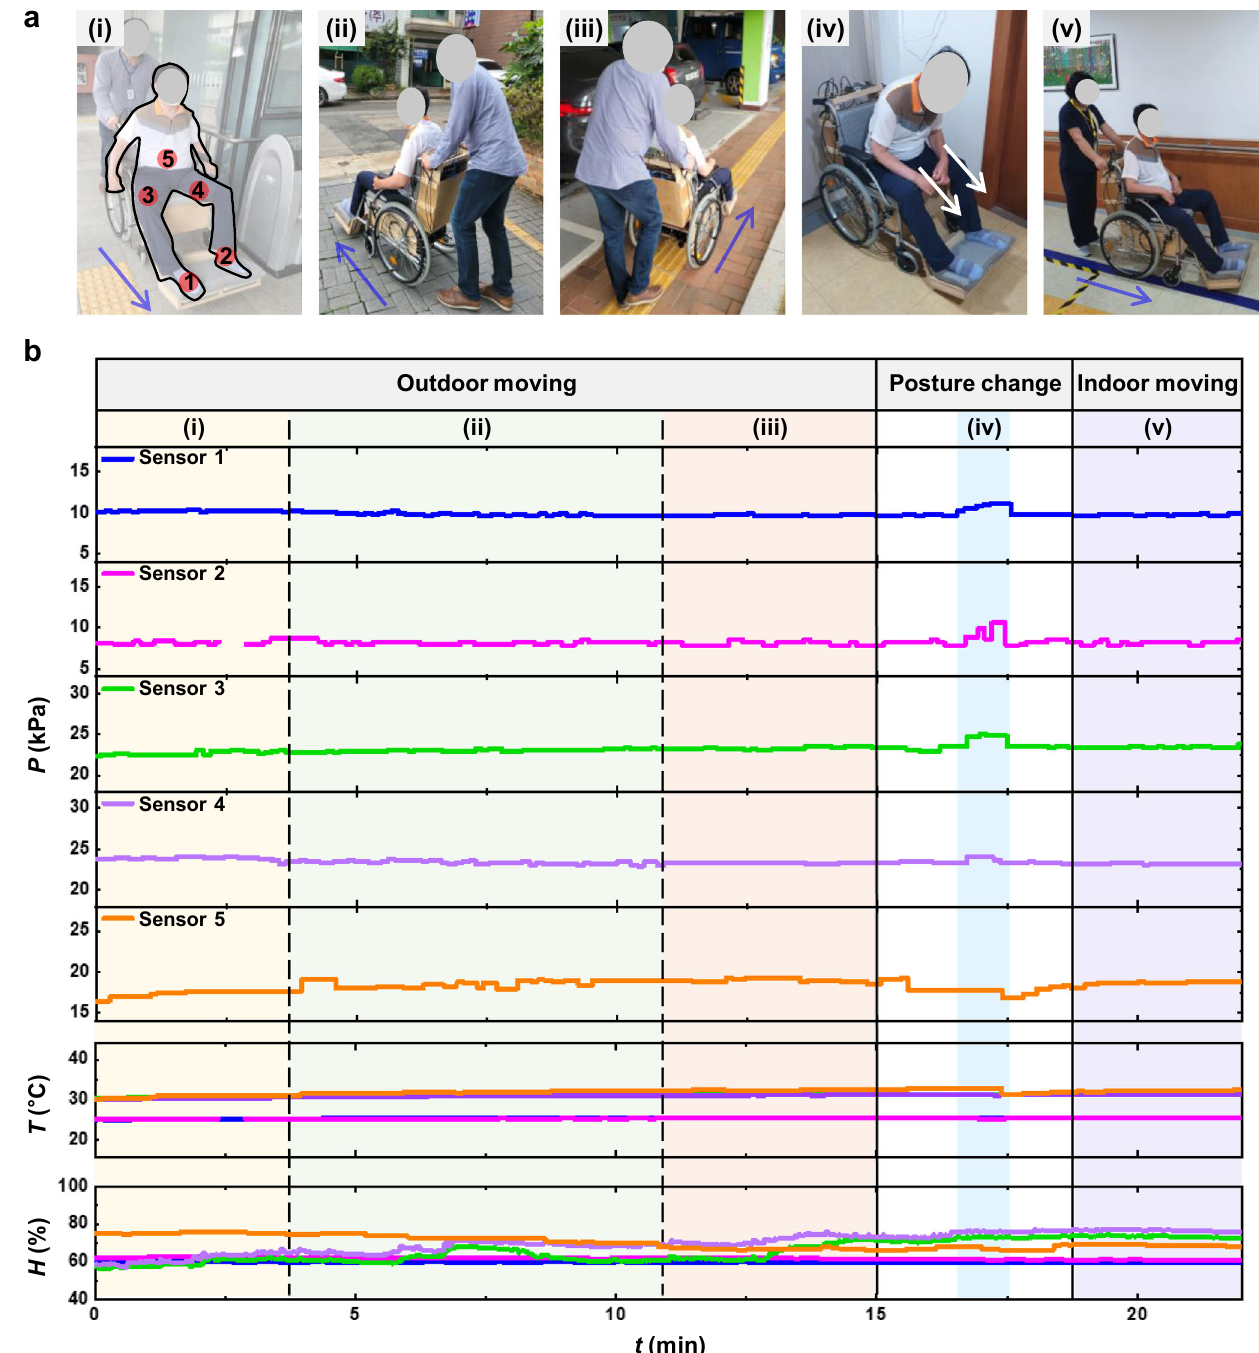
Fig. 7 Continuous measurement of pressure, temperature, and hydration from a paraplegic patient with spinal cord injury that regularly came to the hospital for outpatient treatment. a Photographs of wheelchair moving and postural changes of the subject for self- repositioning. (i) Outdoor moving with the caregiver. Red discs mark the mounting locations of the devices. (ii) Outdoor moving over uneven sidewalk. (iii) Outdoor moving over smooth sidewalk. (iv) Anterior weight shift. (v) Indoor moving in the hospital. b Results from continuous measurements of pressure, temperature, and hydration from each of the sensors while moving or stationary weight-shift in the wheelchair. The subject agreed with the distribution of these photographs using a content form in Supplementary Fig.